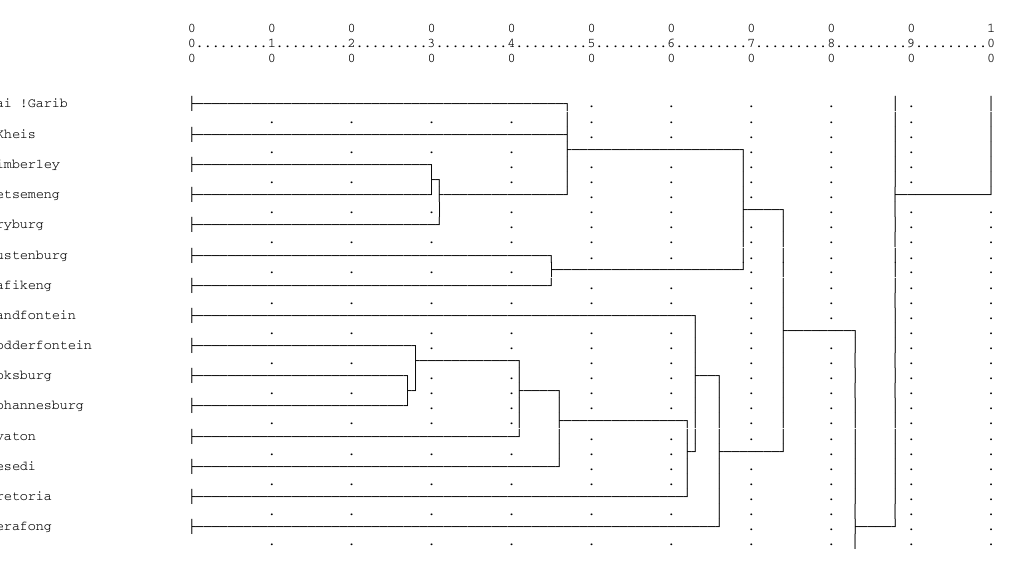
Figure 6 : Dendogram of the last 15 regions in the Gauteng region Figure 6: Dendrogram of the last fifteen regions in the Gauteng region.